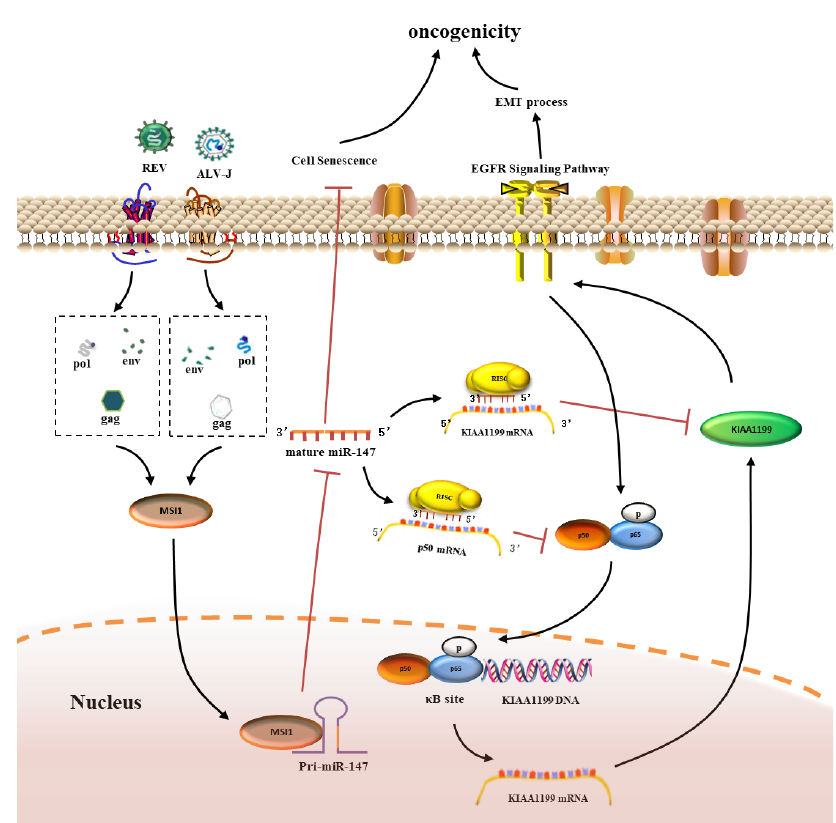
Figure 10. Schematic of the molecular mechanisms of synergistic oncogenicity induced by ALV-J and REV. After co-infection of ALV-J and REV, released or expressed structural proteins from ALV- J and REV in the cytoplasm synergistically elevate the expression levels of MSI1, which directly targets pri-miR-147, causing the inhibition of miR-147 maturation, which relieves the inhibition of the NF- κB/KIAA1199/EGFR signaling pathway and thereby suppress es cellular senescence and ac- tivates the EMT process, promoting oncogenicity.